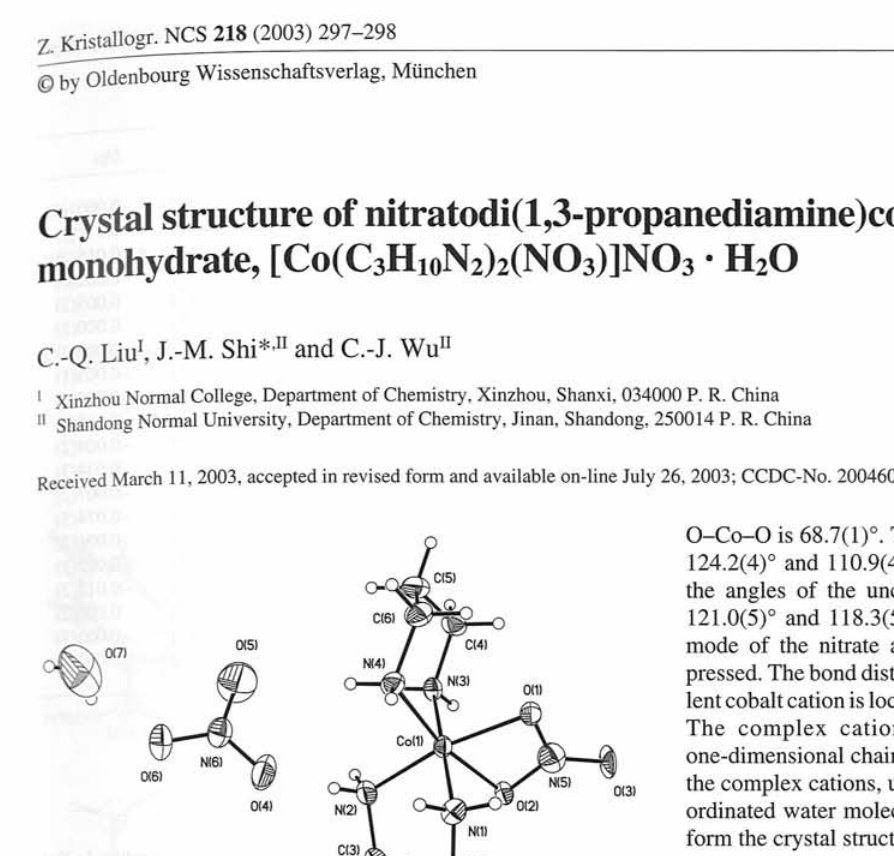
Table 1. Data collection and handling.